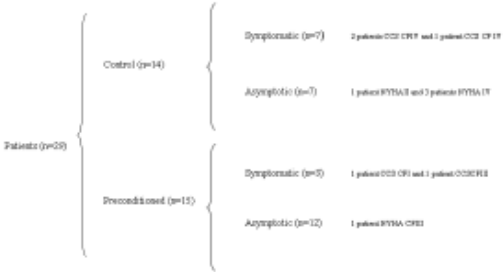
Fig. 1 - Composition of the groups in relation to the cardiac